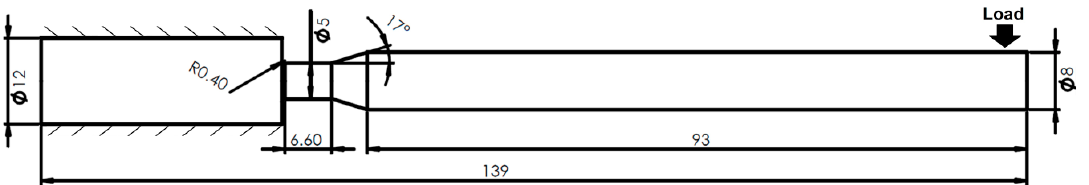
Figure 1. Dimensions of samples evaluated in bending fatigue tests (mm).